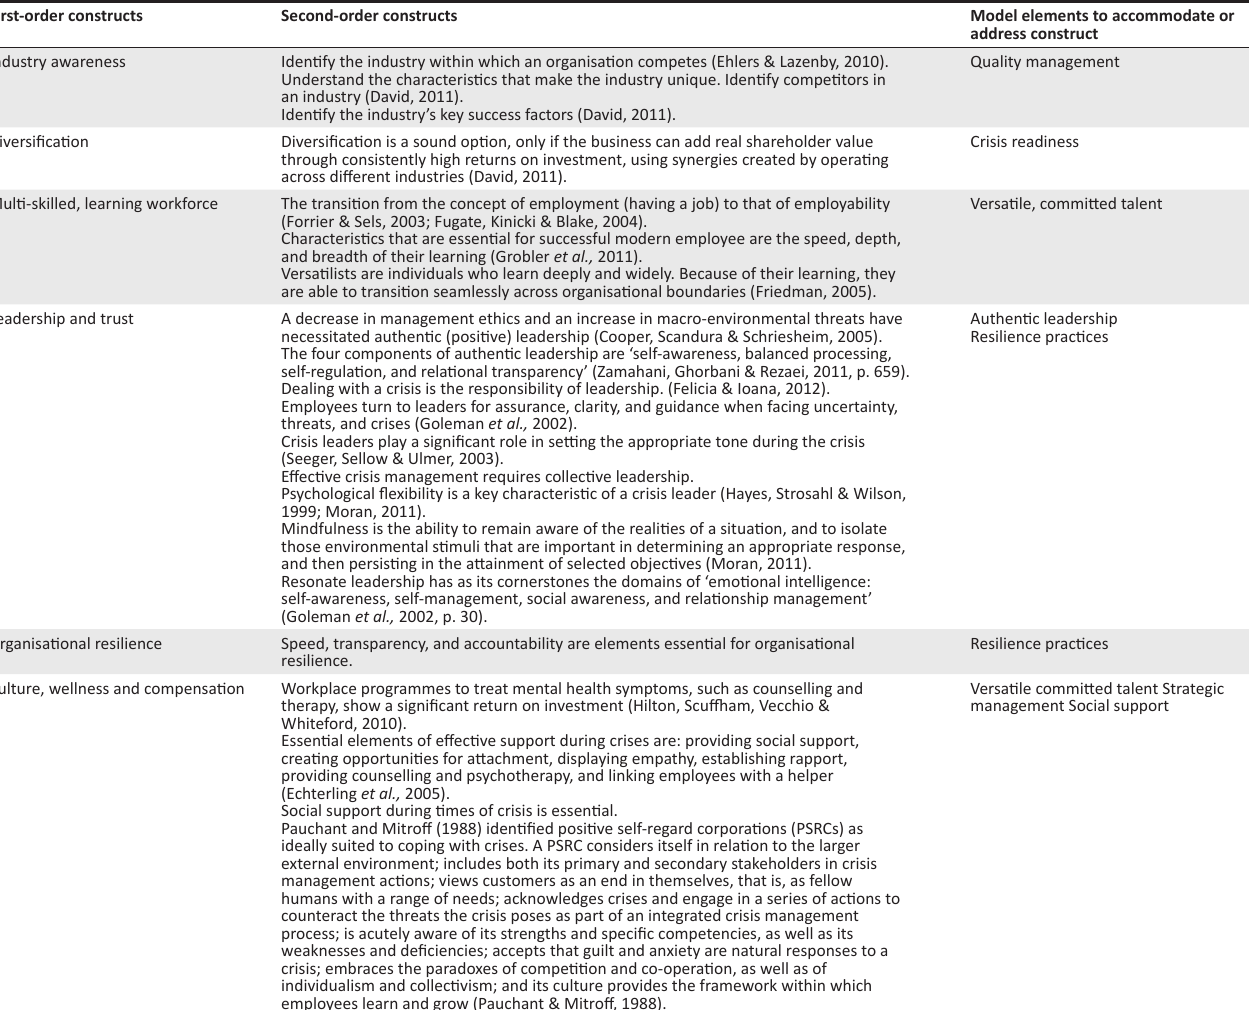
TABLE 3 (Continues...): Elements of the Coherence Hexagons